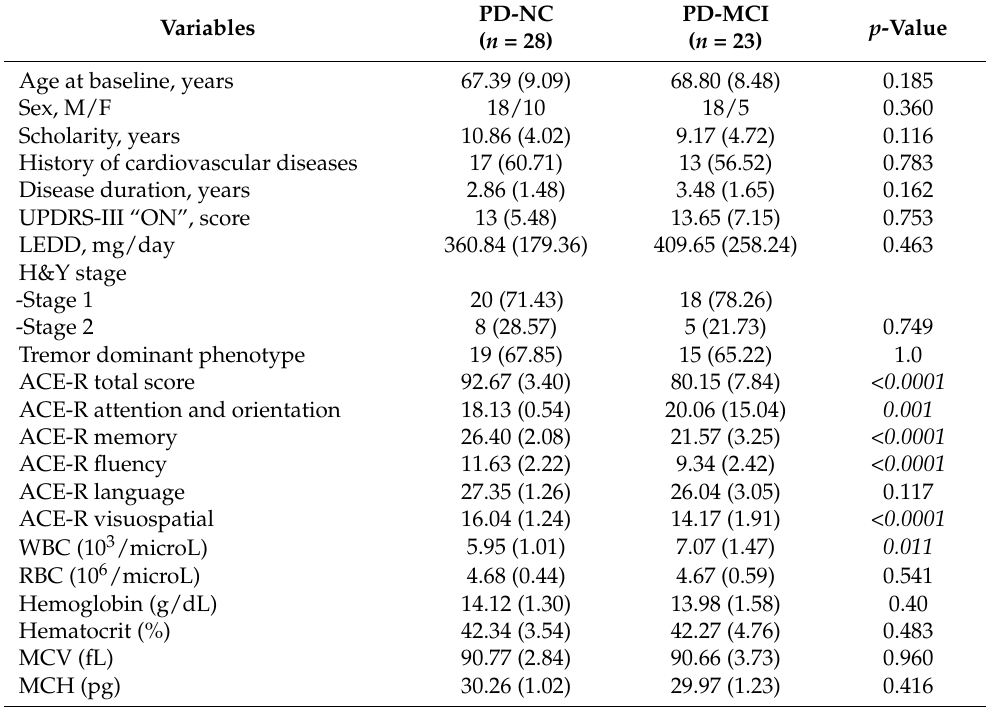
Table 3. Demographic, clinical, and baseline immunological characteristics of PD-NC and PD-MCI